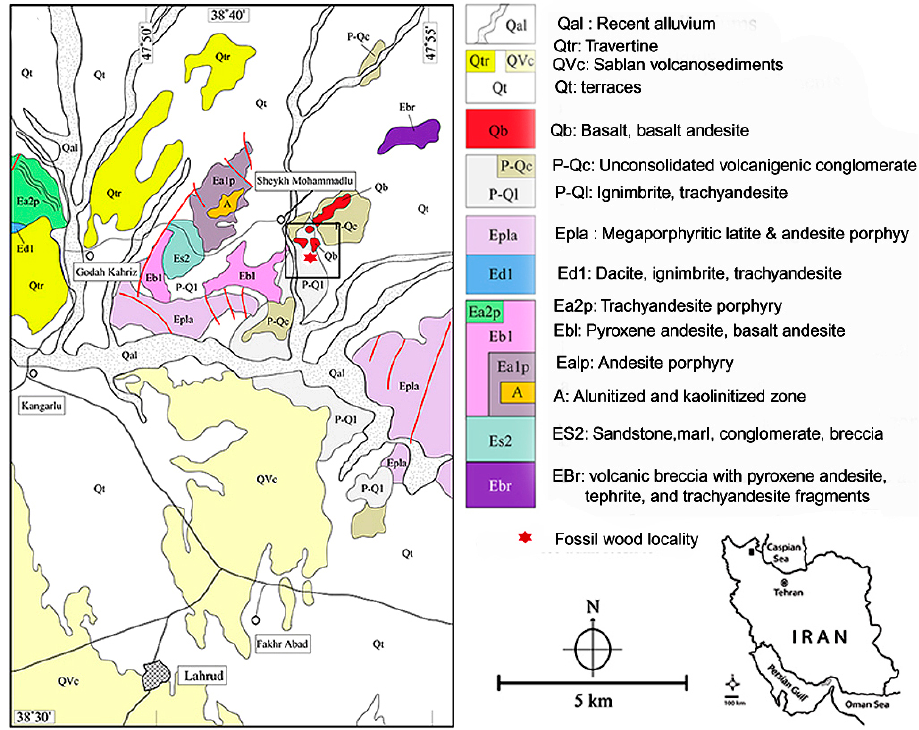
Figure 6. Geology map of fossil forest area includes Eocene–Quaternary rock units. Modified from